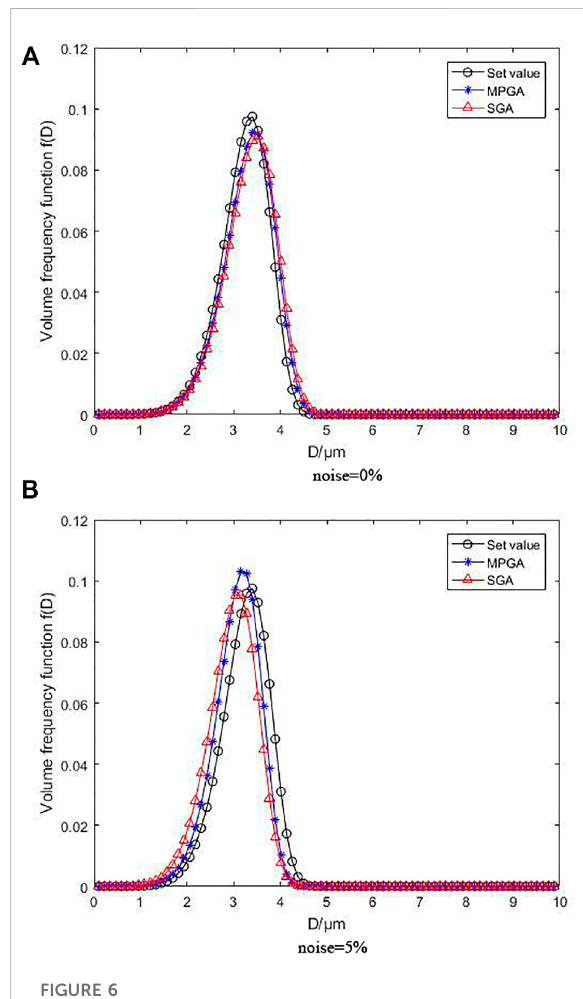
FIGURE 6 Inversion results following unimodal distribution with different